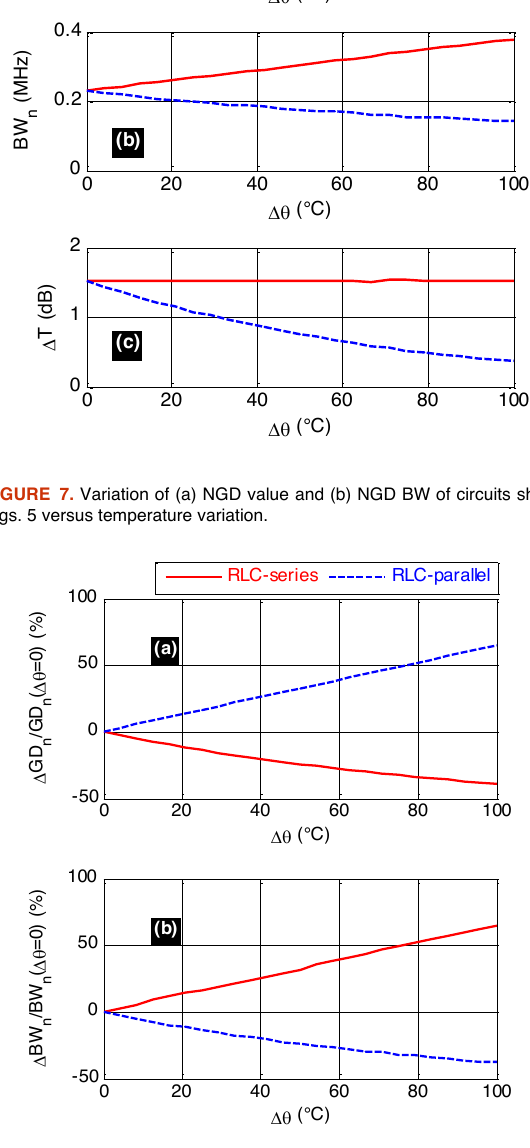
FIGURE 8. Relative variations of (a) NGD value and (b) NGD BW versus temperature variation.